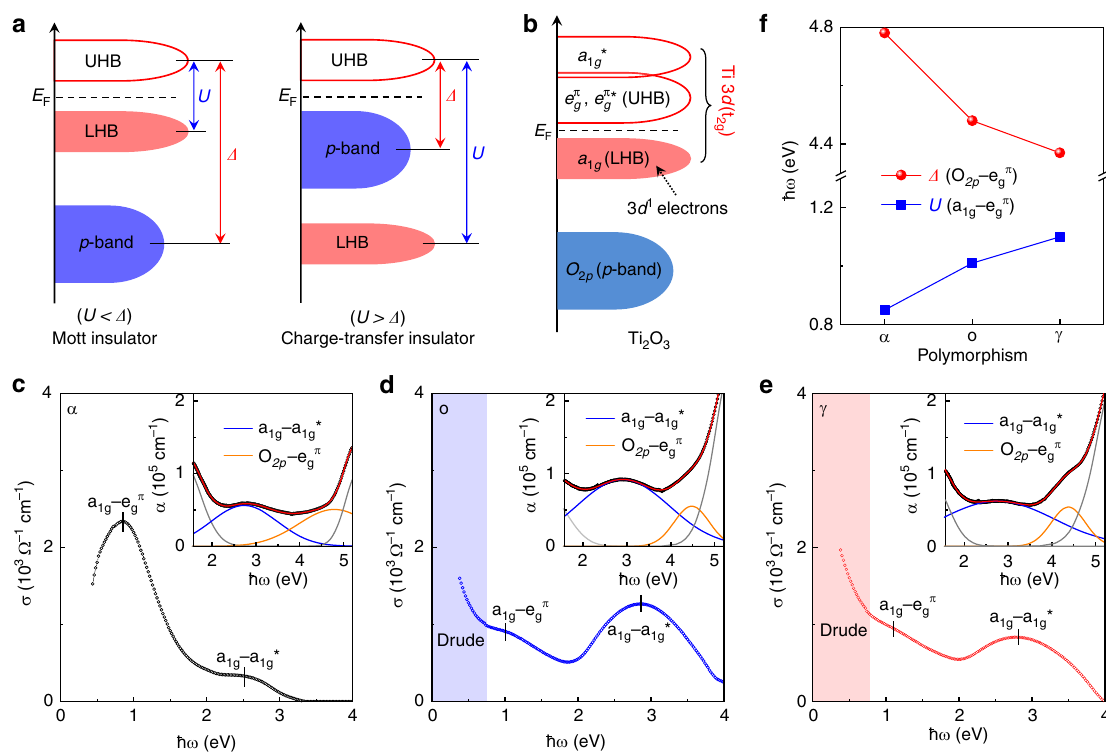
Fig. 3 Electronic reconstructions in Ti 2 O 3 polymorphs. a Schematic energy band diagram for the Mott insulator and charge-transfer insulator. b Proposed electronic structure of Ti 2 O 3 by Goodenough et al. 52 c – e Optical conductivity spectra of the α -, o-, and γ -Ti 2 O 3 polymorphs, taken by the ellipsometry at room temperature. Insets are the corresponding absorption coef fi cient ( α ) of the Ti 2 O 3 polymorphs, collected by the UV – Vis spectroscopy at room temperature. f Evolution of the U and Δ in Ti 2 O 3 polymorphs. Source data are provided as a Source Data fi